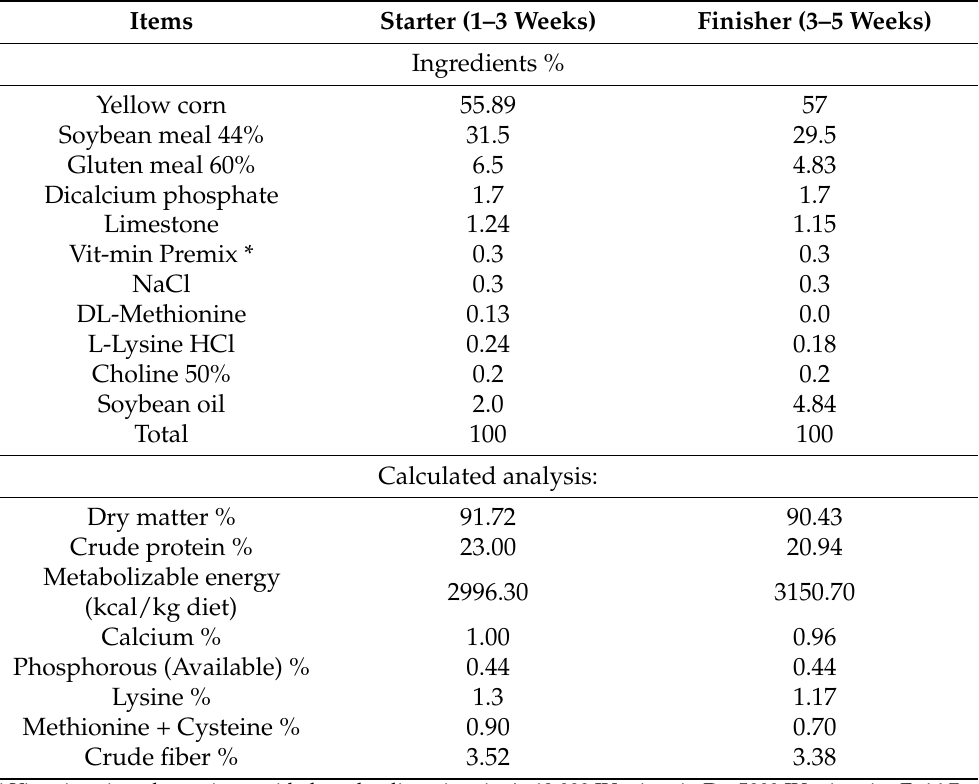
Table 1. Composition and chemical analysis of the starter and finisher basal diets (as